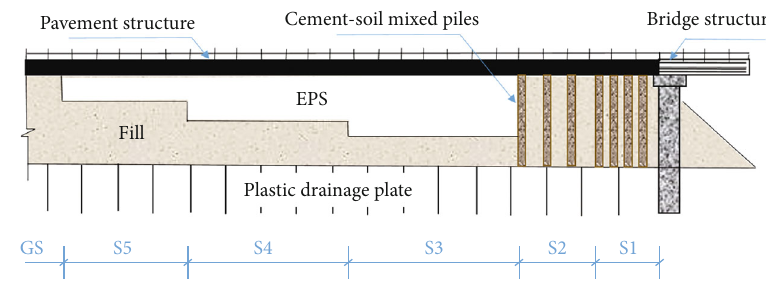
Figure 9: Schematic diagram of bridge approach.